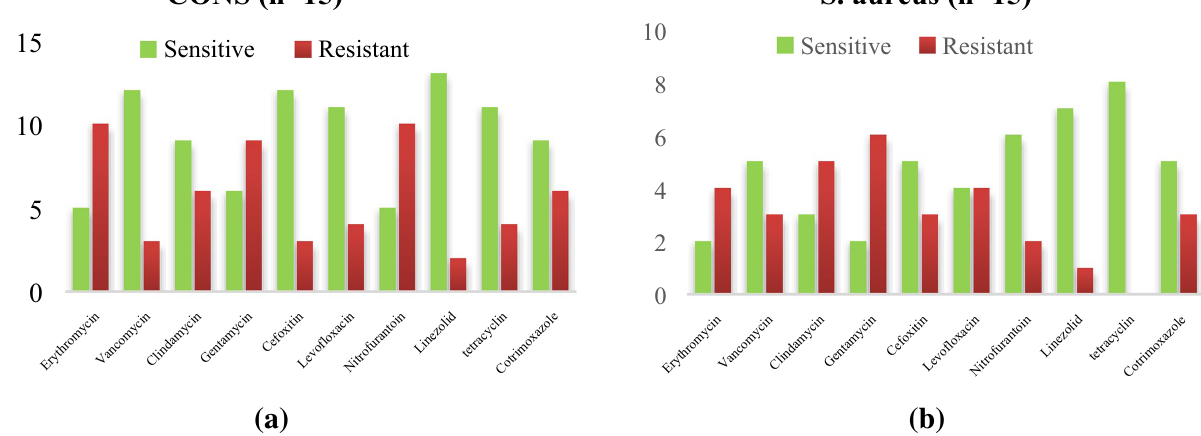
Figure 4. Antibiogram of CoNS and S. aureus Isolated from the nares of Health workers. ( a ) Antibiogram of CoNS isolated from anterior nares of health care worker in PICU. ( b) Antibiogram of S.aureus isolated from anterior nares of health care worker in PICU. Out of 30 nasal specimen, predominant isolate was CoNS with a good sensitivity for linezolid (13/15), vancomycin (12/15) and MRSA were produced by 3 isolates in contrast to S.aureus , good sensitivity was observed for tetracycline (8/8) followed by linezolid (8/8) and Nitrofurantoin (6/8) and 3 isolates produce MRSA.